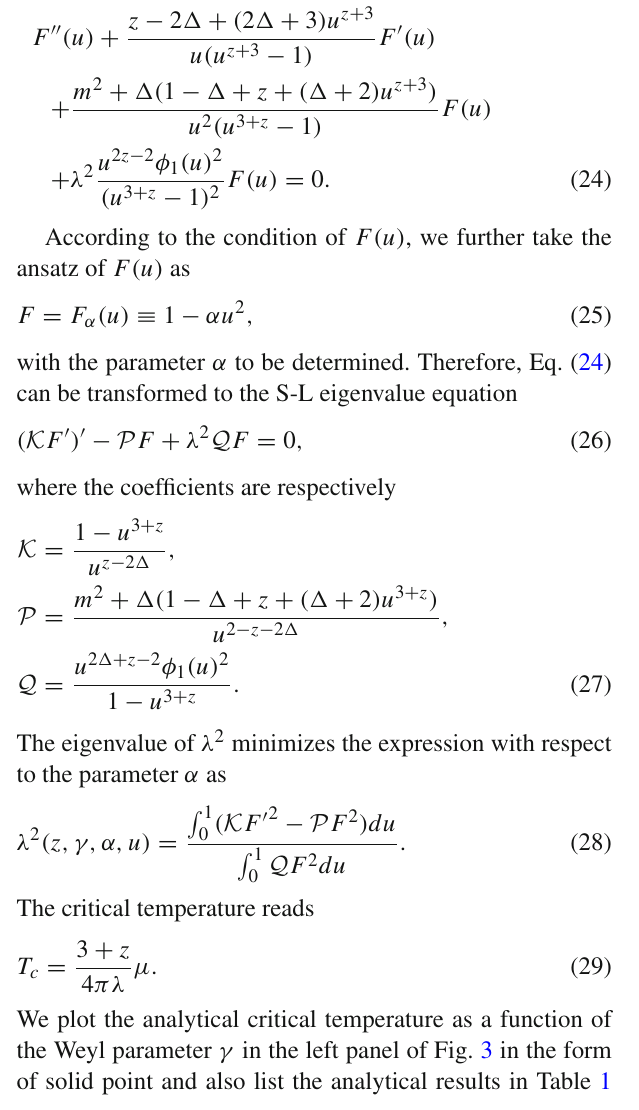
with 2 (red) and 2